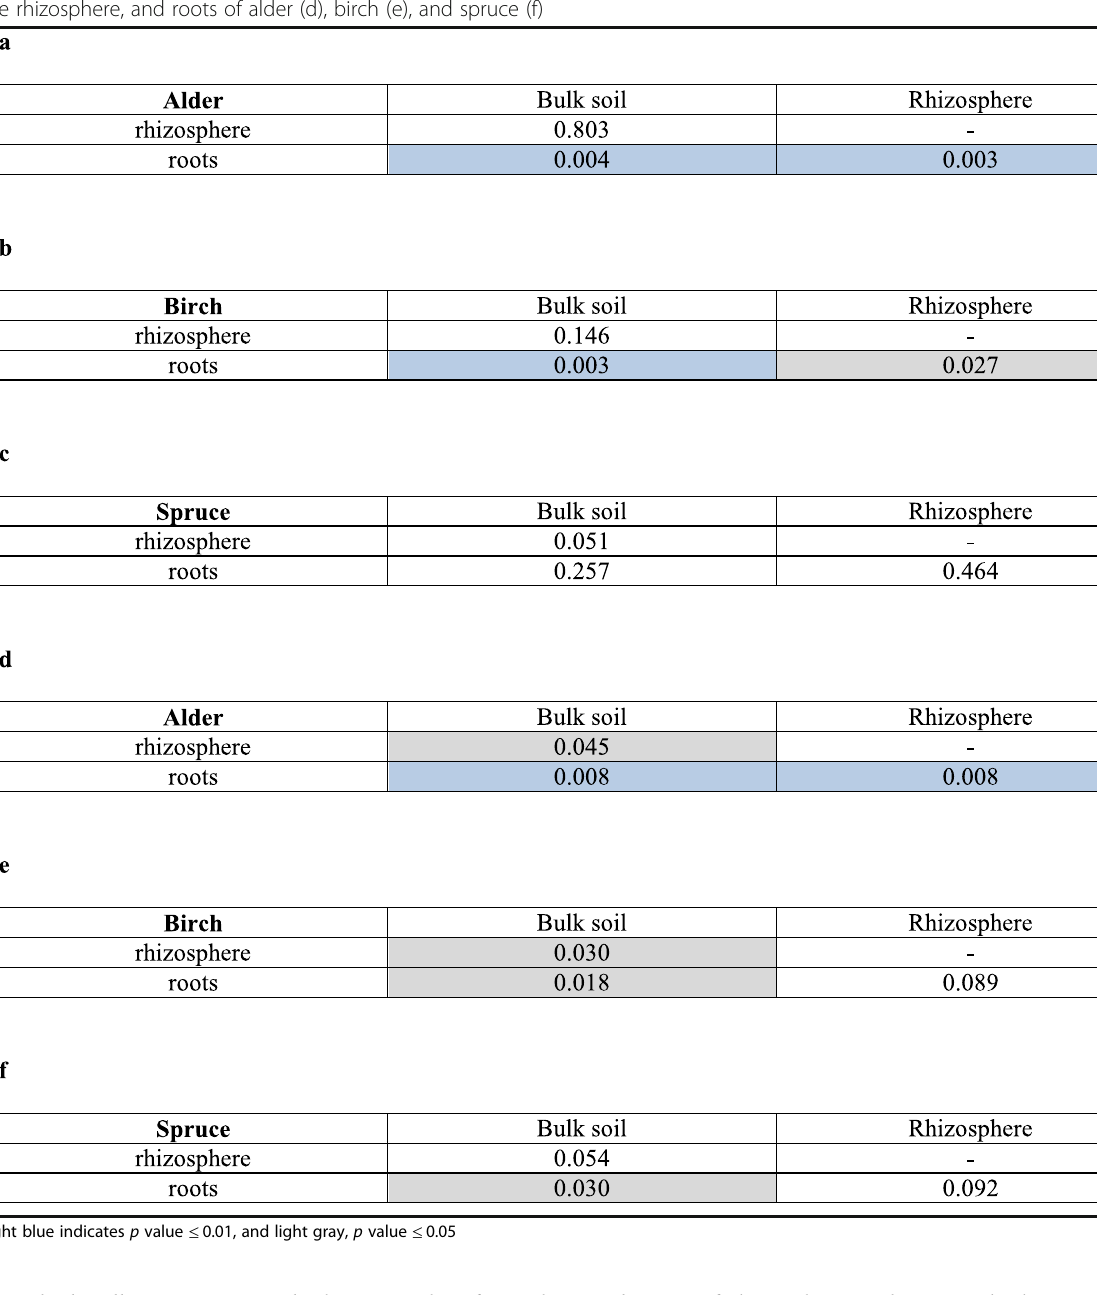
Table 2 MANOVA test result (nperm = 999) performed on data presented in Fig. 3. Bacterial community comparisons between bulk soil, the rhizosphere, and roots associated with alder (a), birch (b), and spruce (c). Fungal community comparisons between bulk soil, the rhizosphere, and roots of alder (d), birch (e), and spruce (f)